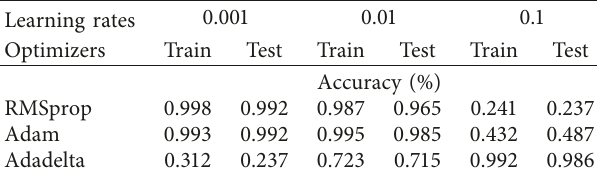
Table 2: Accuracy of different optimizers and learning rates. Learning rates